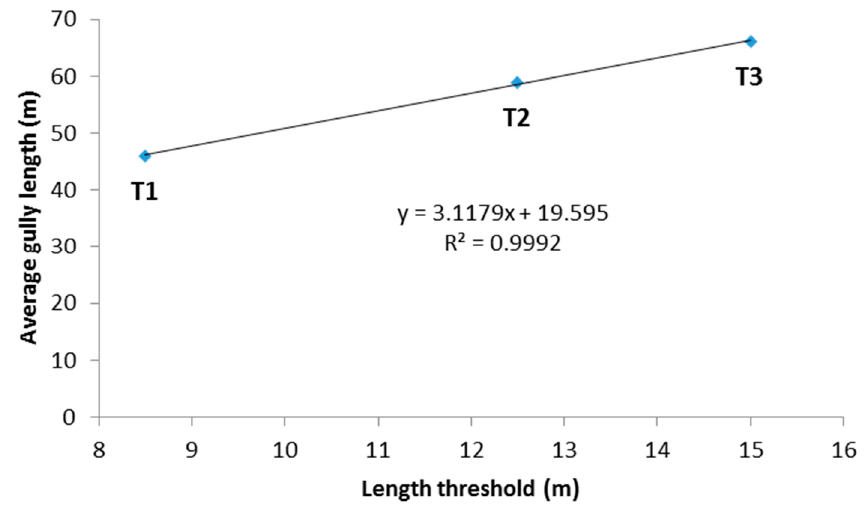
Figure 11. The relationship between the length threshold and the average gully length in three test areas.